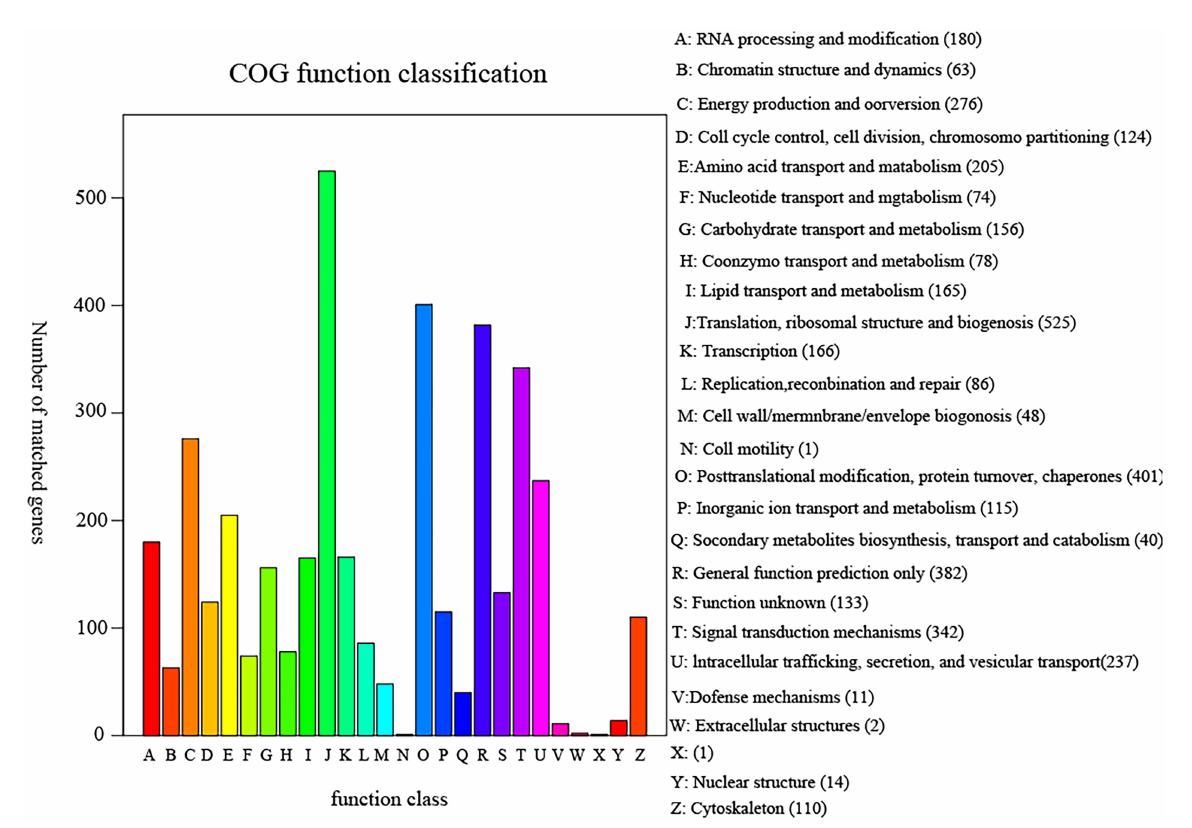
FIGURE 4 COG functional classification diagram of sample Y5 gene function annotation. COG (Cluster of Orthologous Groups of proteins) is constructed based on the classification of phylogenetic relationships of proteins encoded in complete genomes of bacteria, algae and eukaryotes. By comparison, a protein sequence can be annotated to a particular COG, and each cluster of COGs consists of direct homologous sequences, allowing the function of that sequence to be inferred. The abscissa represents the type of COG function and the ordinate represents the number of genes on the